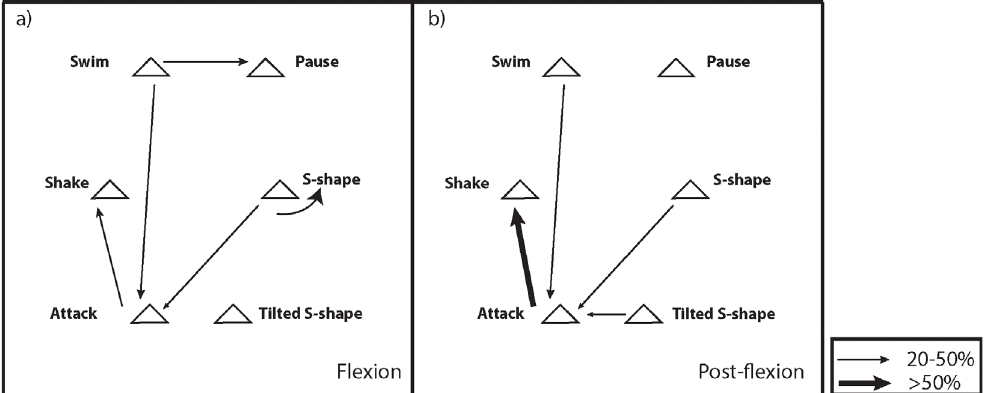
Fig. 3. Synthetic kinematic diagrams illustrating the most frequent feeding behavioral transitions during (a) fl exion and (b) post- fl exion. The light arrows indicate a behavioral transition of 20 – 50%, the bold arrows indicate a behavioral transition of > 50%.